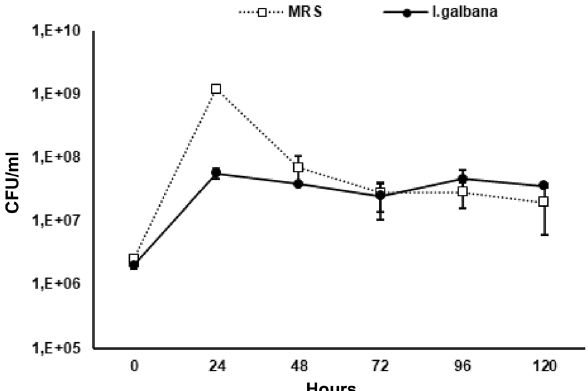
Figure 1. Anaerobiotic growth of L. reuteri in the marine microalga I. galbana . The probiotic L. reuteri was able to grow in I. galbana as well as in the commercial medium. L. reuteri Lactobacillus reuteri , I. galbana Isochrysis galbana , MRS commercial